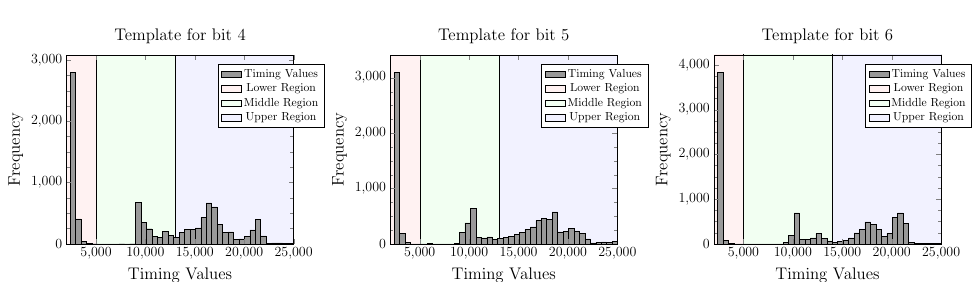
Figure 8: Three different regions observed in the templates for bit 4, bit 5, and bit 6 for bit combination